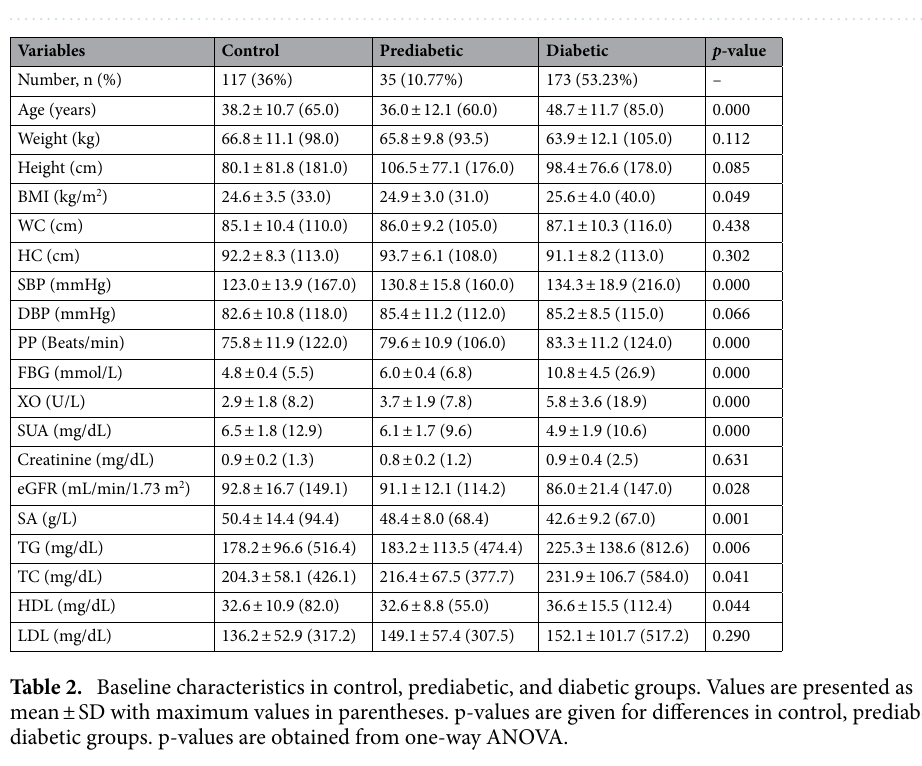
Figure 1. Age and sex-specific mean serum levels of FBG, XO, and SUA.